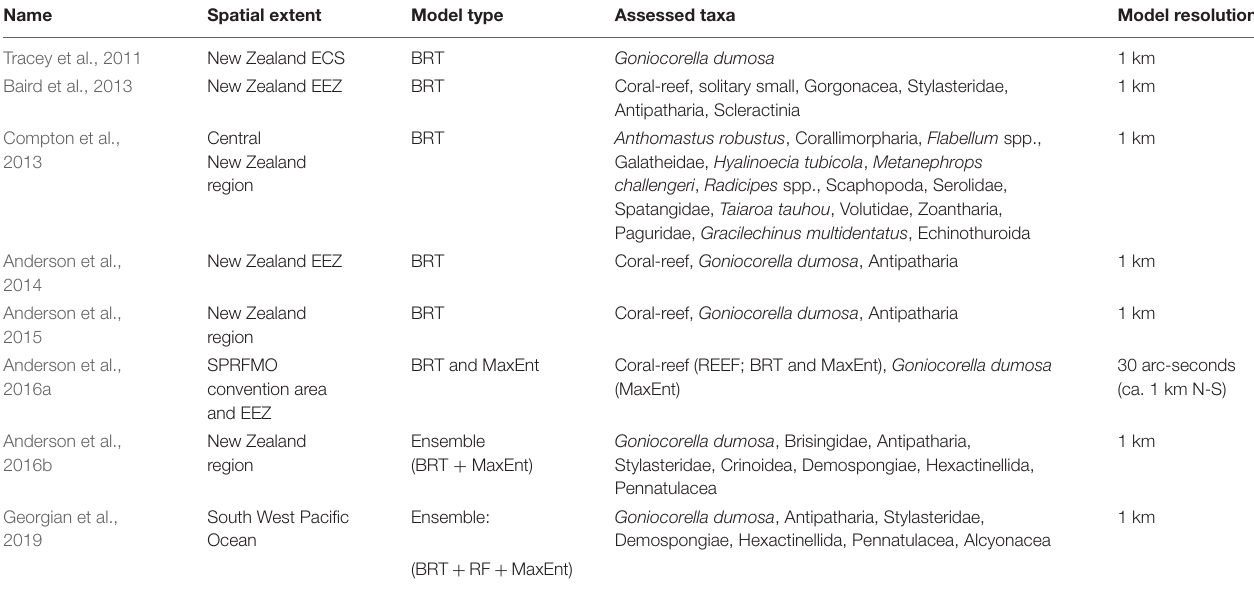
TABLE 1 | Summary details of the eight existing SDM studies and the individual models suitable for assessment against the independent